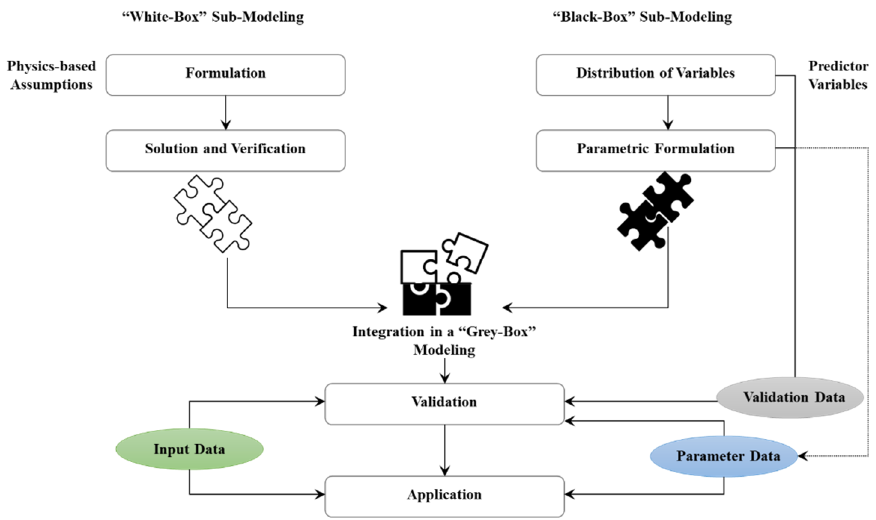
Figure 3. Schematic of the development process of a “grey-box” model, reprinted with permission from Ref. [84].